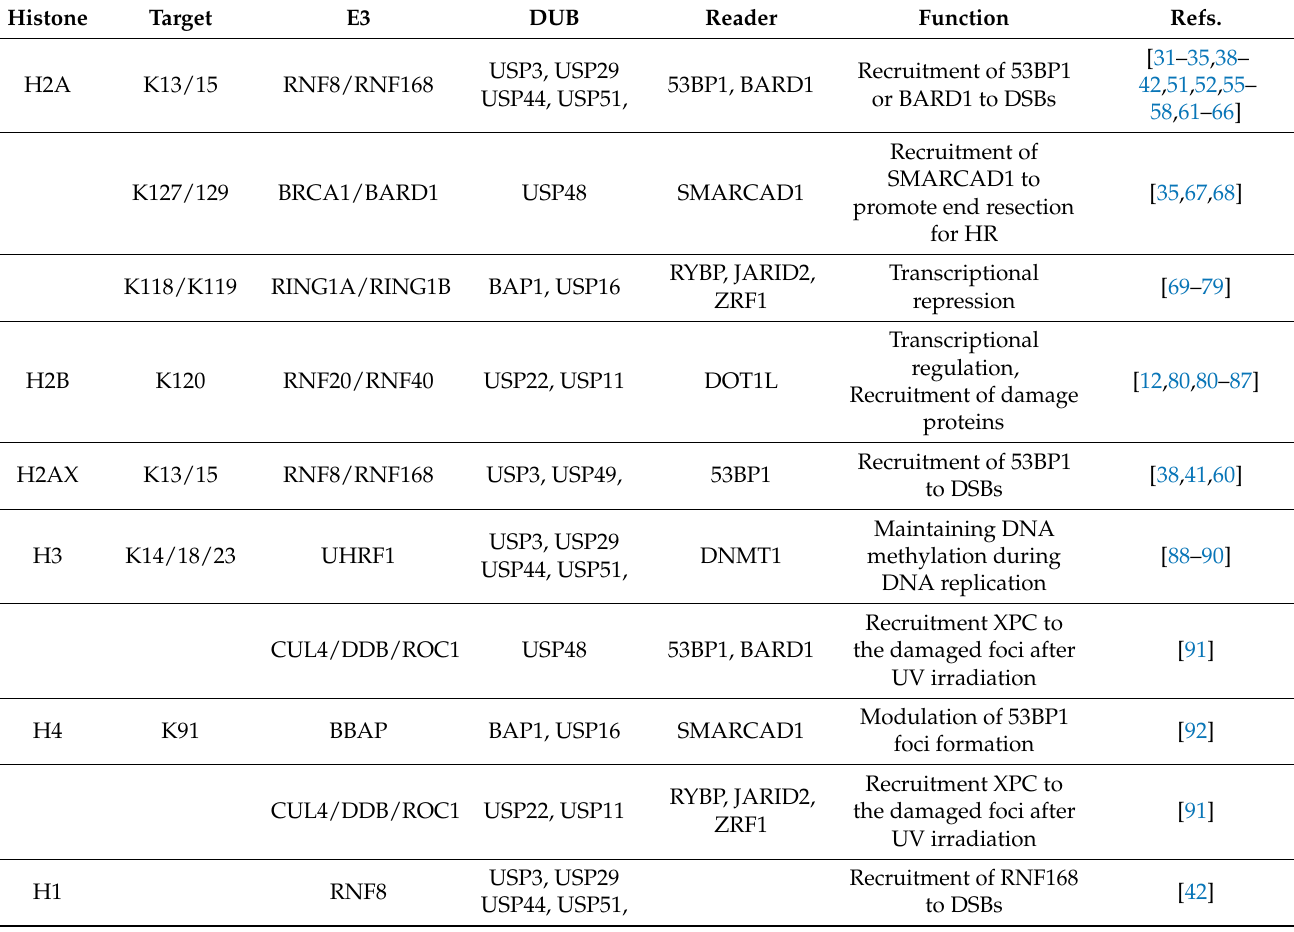
Table 1. Histone lysine ubiquitination enzymes and deubiquitination enzymes involved in DNA damage